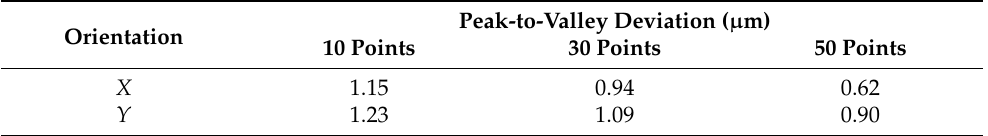
Table 1. PSD output signals processed by digital filter.